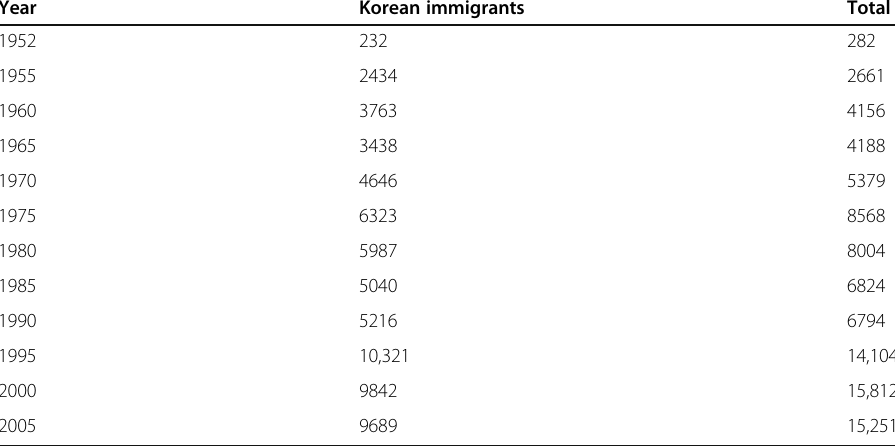
Table 1 Annual naturalizations in